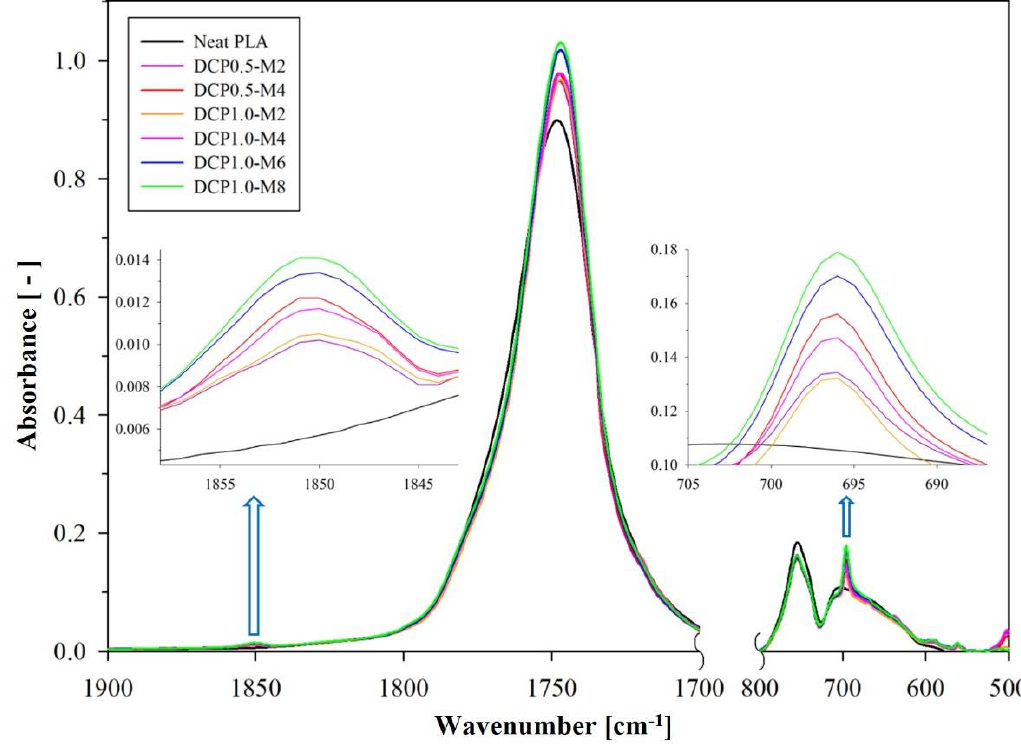
Figure 2. Details of FT-IR spectrum (1900 – 1700 cm −1 and 800 – 500 cm −1 ) for neat PLA and PLA-g- MAH with variable MAH and DCP contents.